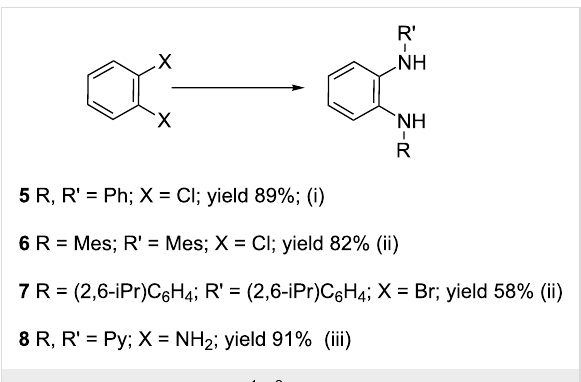
an earlier synthetic route [46] (Scheme 1). In the case of com- pound 5 a better yield (89%) could be accomplished when the reaction was carried out at 92 °C instead of 120 °C as reported